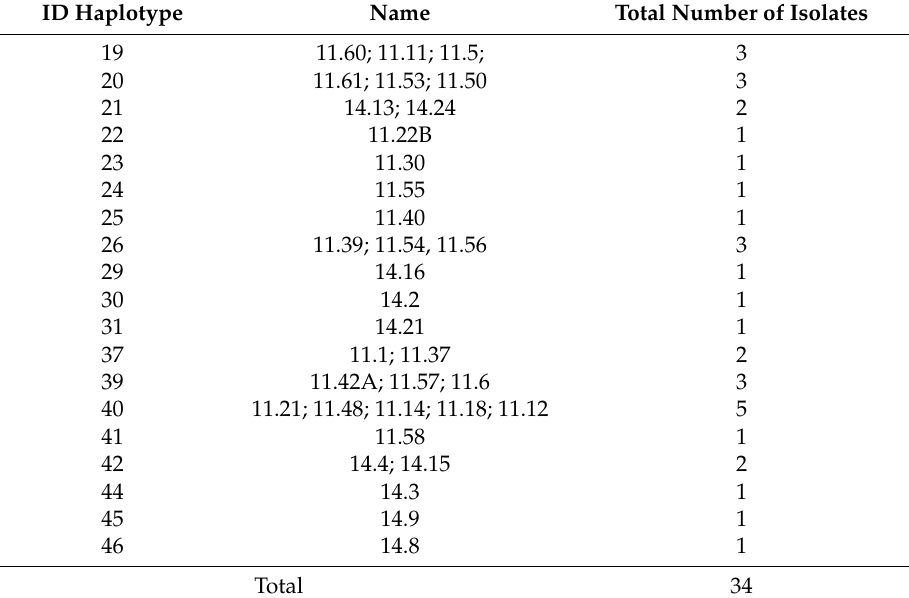
Table 3. Distribution of Acinetobacter RAPD haplotypes.